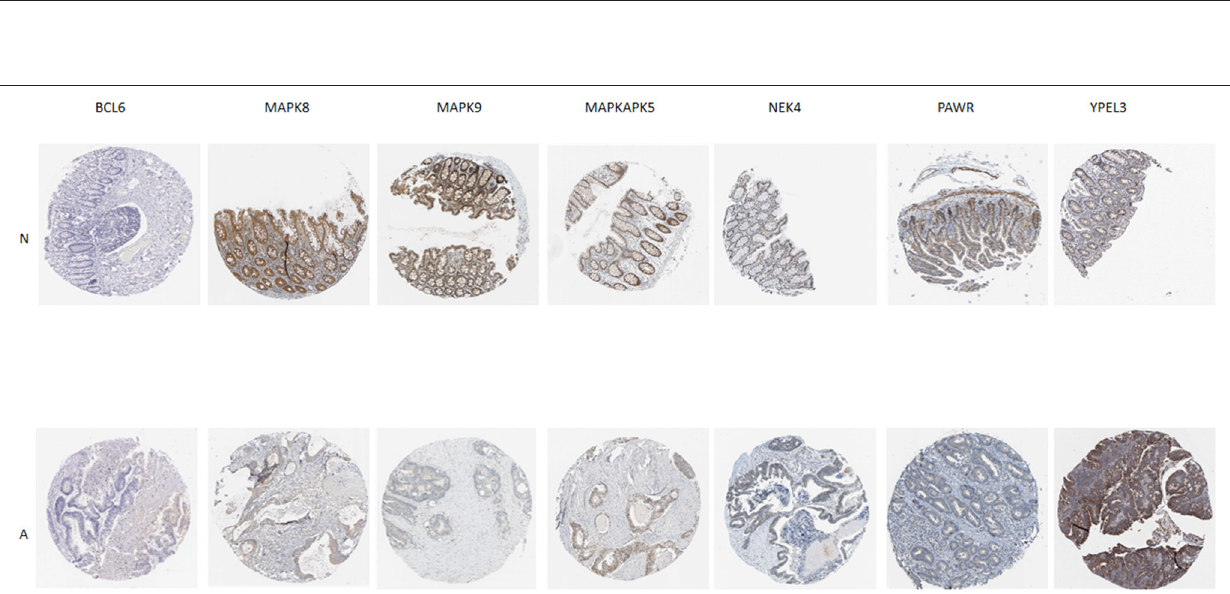
Frontiers in Medicine |